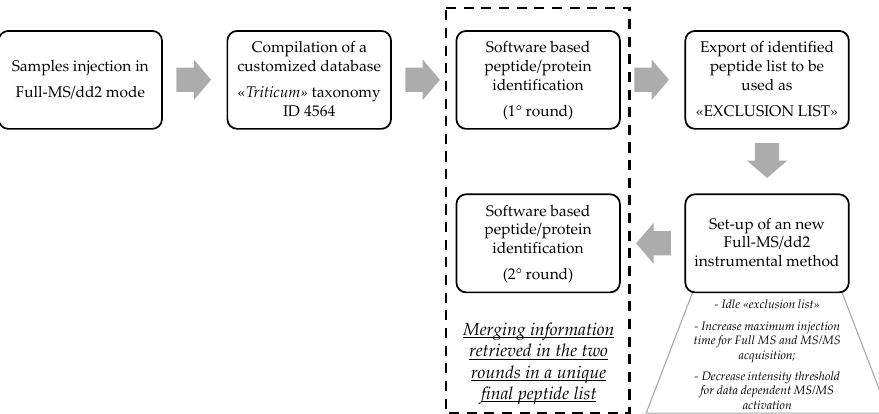
Figure 3. Workflow of the two-round identification protocol applied to maximize the number of GD resistant peptides identified.